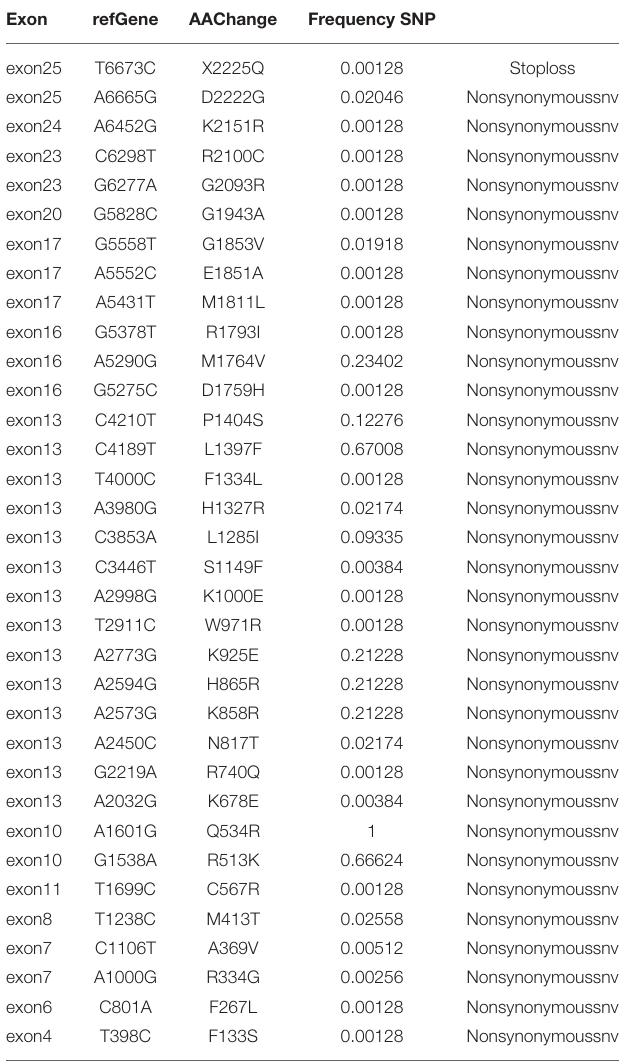
TABLE 3 | The nonsynonymus mutations in non-FV deficiency patient population. Exon